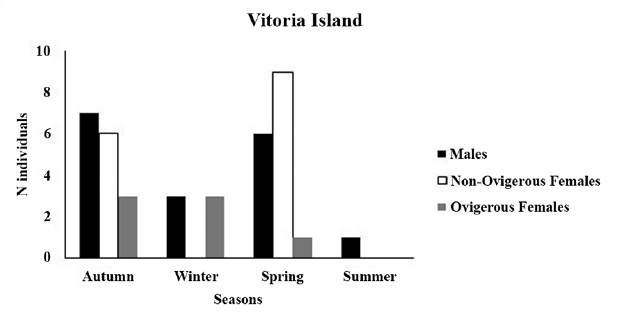
Figure 3. Abundance of Alpheus formosus individuals during all seasons (2015–2016) collected at Laje de Santos, São Paulo State, Brazil.